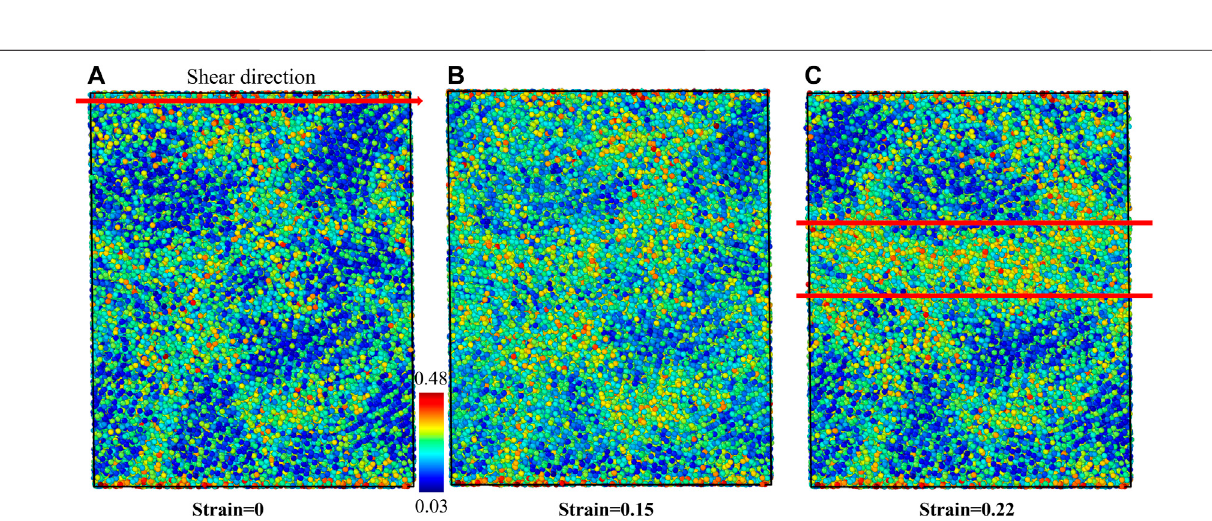
FIGURE 4 | The atomic von-Mises strain map of G-phase under the shear deformation. (A) The intact structure, (B) the structure at 0.15 shear strain before the initiation of shear band, and (C) the structure at 0.22 shear strain after forming the shear band.